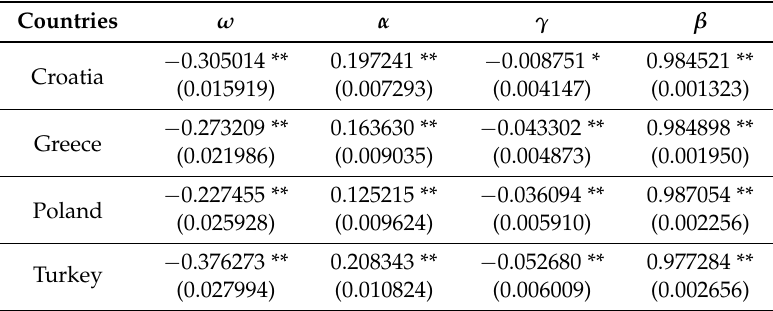
Table 5. EGARCH (1.1) parameters of the log returns of the original series.